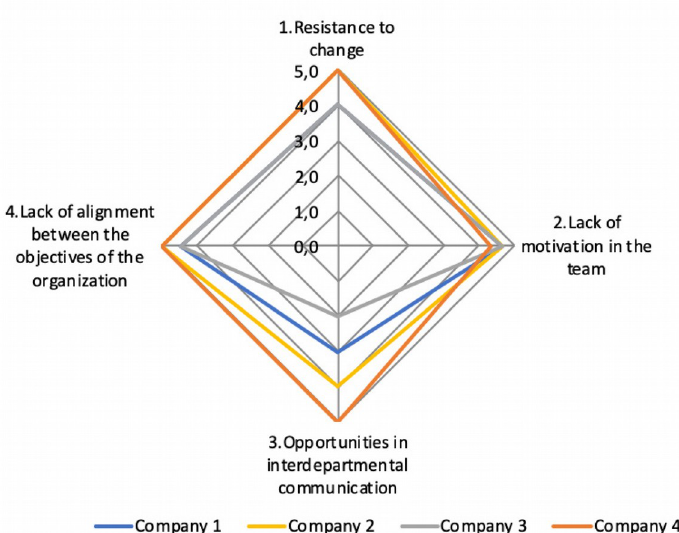
Figure 2. Results of the assessment of the major barriers for companies C1, C2, C3 and